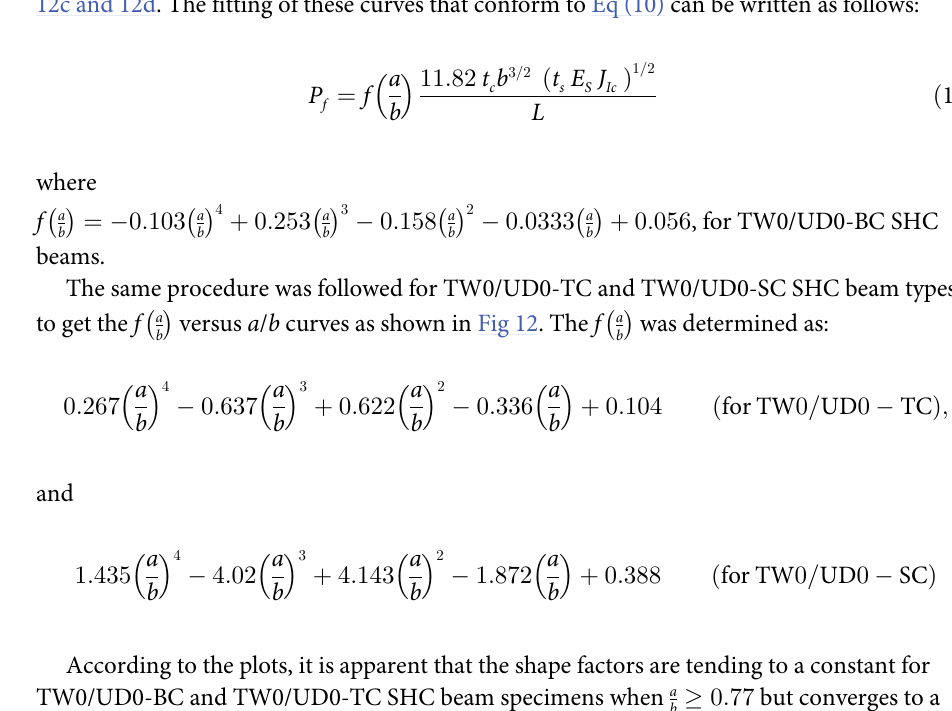
Fig 12. a) J -integral and load versus time curves for a crack and, the corresponding f a